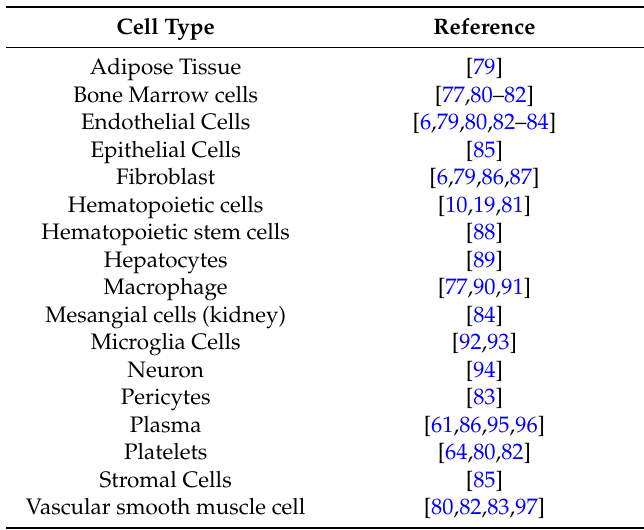
Table 2. Various Cell-types producing